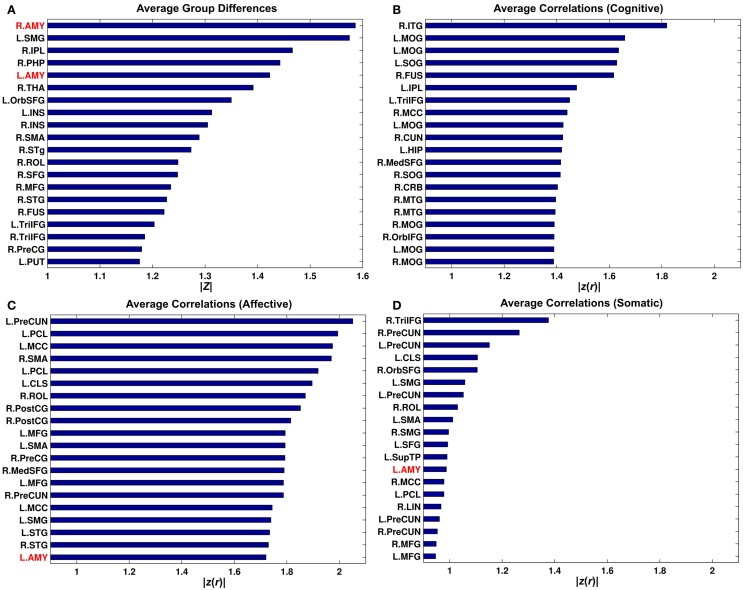
Bar graphs for average group differences (A) and average correlation between connectivity strength and the Buckley BDI sub-scores (B-D) over 268 putative functional nodes. Only top 20 nodes for each of the measures were shown. See Cao et al. (109) for abbreviations for node names.